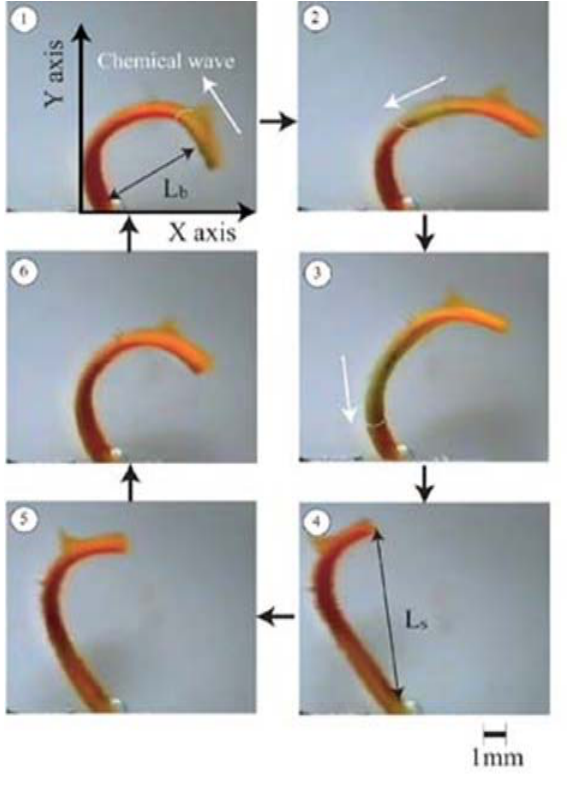
24. Images of the repeated bending and stretching motion of the poly[NIPAAm-co-Ru(bpy)3-co-AMPS] gel strip (R10-A3) in the mixture solution of the BZ substrates. First, the whole gel strip was homogeneous reduced state. Second, the gel strip is in a locally oxidized state when the chemical wave propagates in the gel from one edge to the other edge (1 → 4). Finally, the whole gel strip change reduced state, and was bending (5 → 6). Reprinted from Reference [284] with